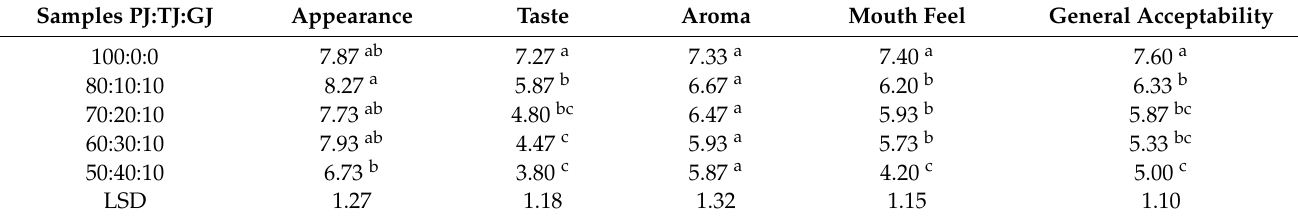
Values are means of two duplicate determinations. Means in the same column with the same superscript are not significantly different ( p > 0.05), Key: PJ = Pineapple juice; TJ = Turmeric juice; GJ = Ginger juice LSD = Least significant